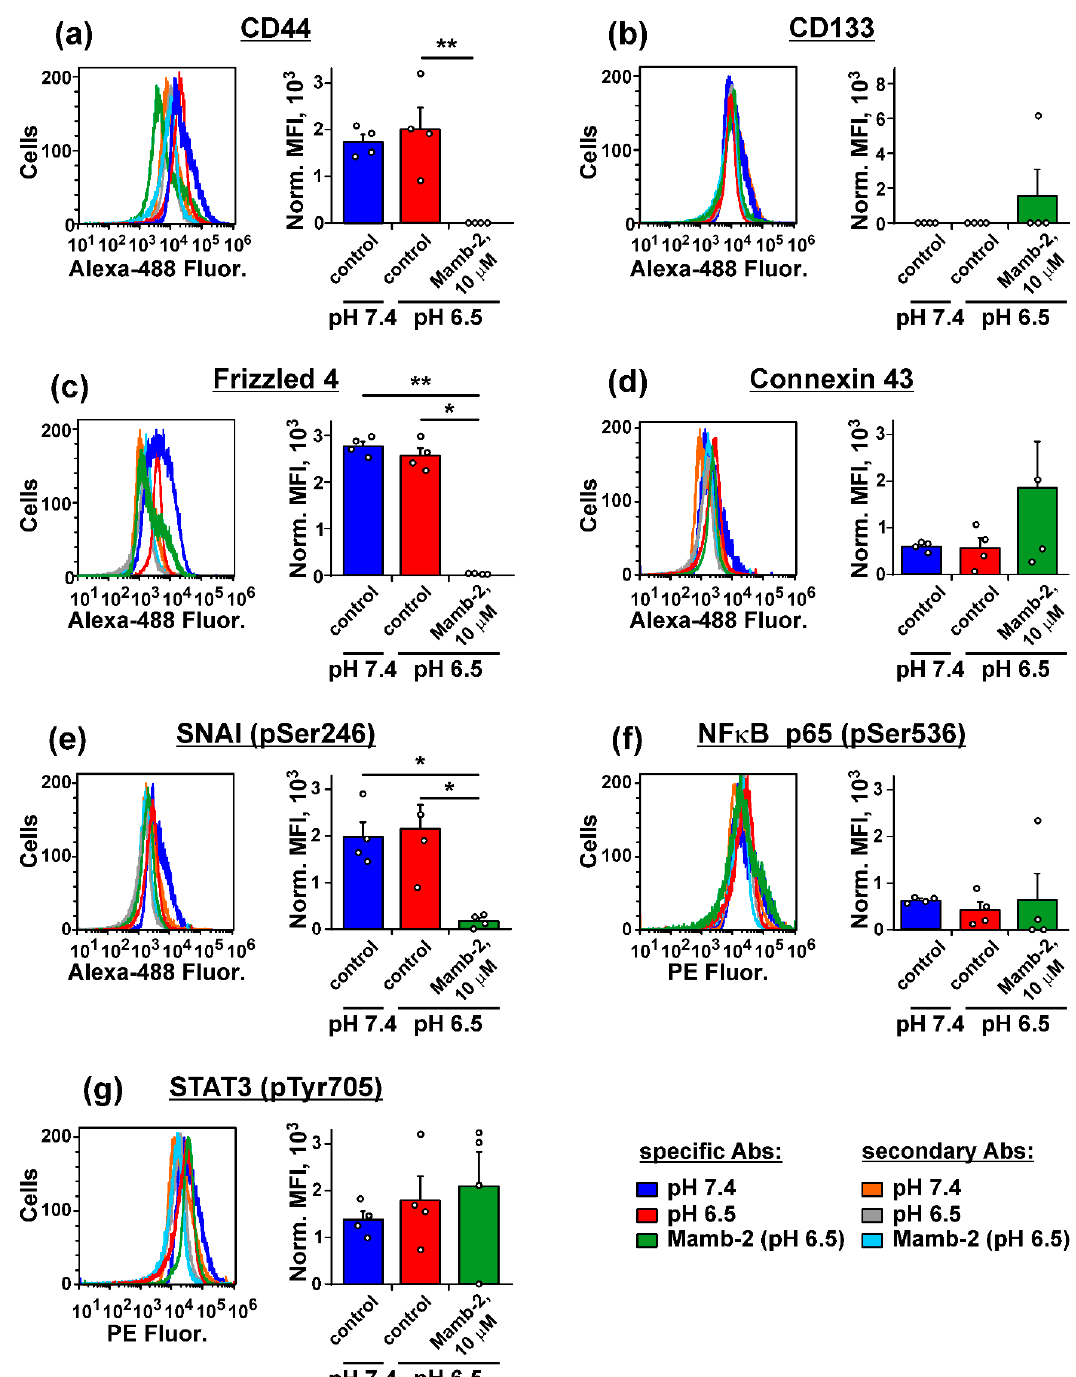
Figure 8. Analysis of influence of cell media acidification (96 h) and 10 μ M mambalgin-2 (72 h) on expression and activity of molecules mediating progression in mel P cells: CD44 ( a ), CD133 ( b ), Frizzled 4 ( c ), connexin 43 ( d ), SNAI (pSer246) ( e ), NF κ B p65 (pSer536) ( f ), and STAT3 (pTyr705) ( g ). Analysis was performed by flow cytometry. The representative cell distribution histograms after staining by antibodies and expression levels are shown at the left and right figure panels, respectively. Data presented as normalized MFI ± SEM ( n = 4). * ( p < 0.05) and ** ( p < 0.01) indicate significant difference between the data groups by One-Way ANOVA followed by Tukey’s hoc test. Cells stained only by secondary antibodies (Abs) were used as a negative control.